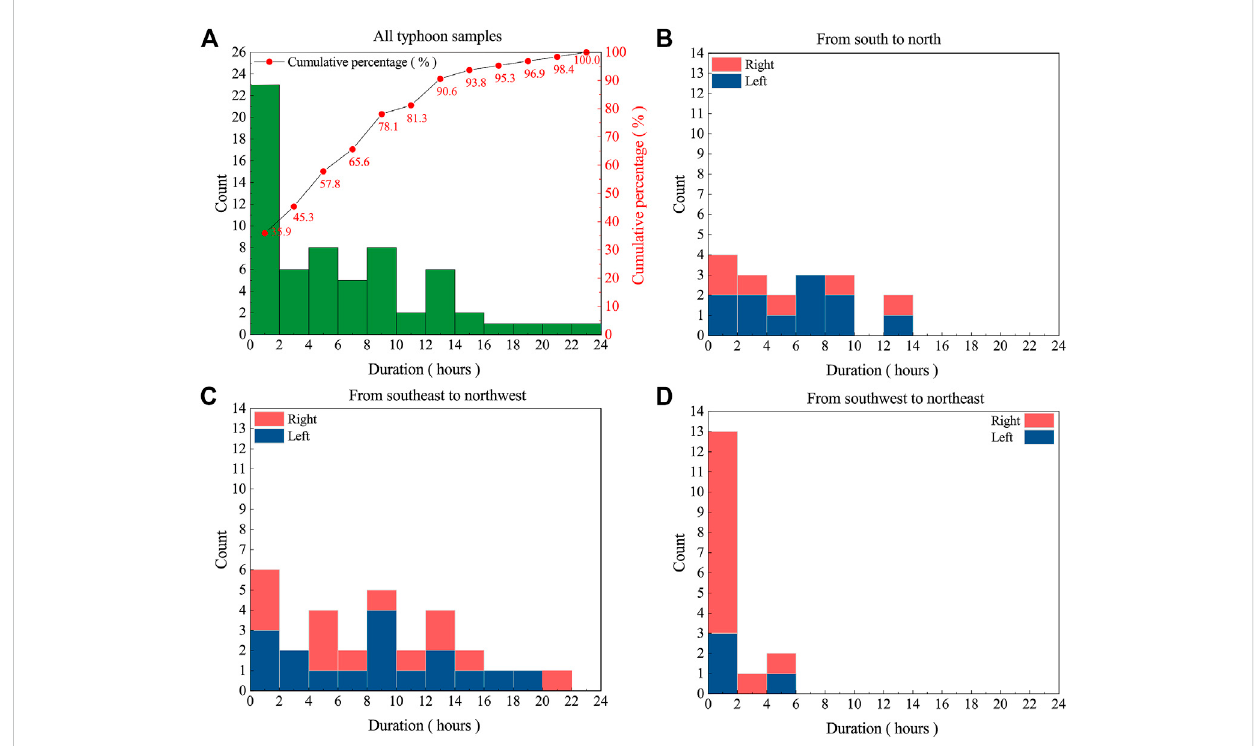
FIGURE 6 Durationfrequencydistributionfor (A) alltropicalcyclonesandthosemoving (B) northward, (C) northwestward,and (D) northeastwardandaffecting theareaoftheDonghaitangwindfarm.Theorange(blue)colorrepresentsthefrequencyoftropicalcycloneswhosecenterpassedtotheright(left)ofthe wind